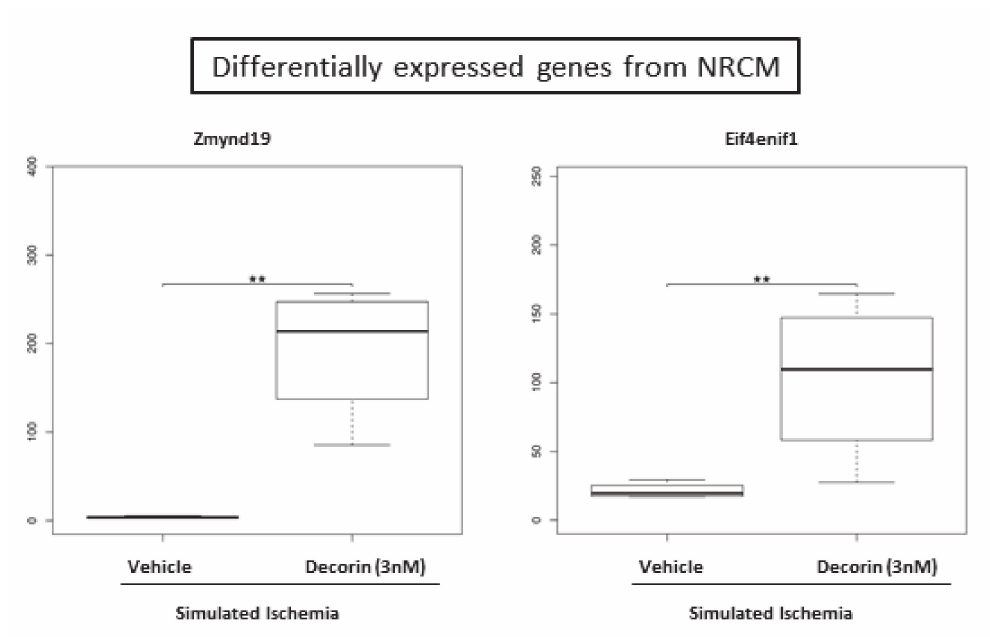
Figure 6. Significantly di ff erentially expressed mRNAs in the decorin-treated NRCM samples compared tothevehicletreatedgroup. p-valuesandcorrectedp-values(false-discoveryrateaccordingtoBenjamini and Hochberg) were calculated by the DESeq2 software package. **denotes corrected p -values <